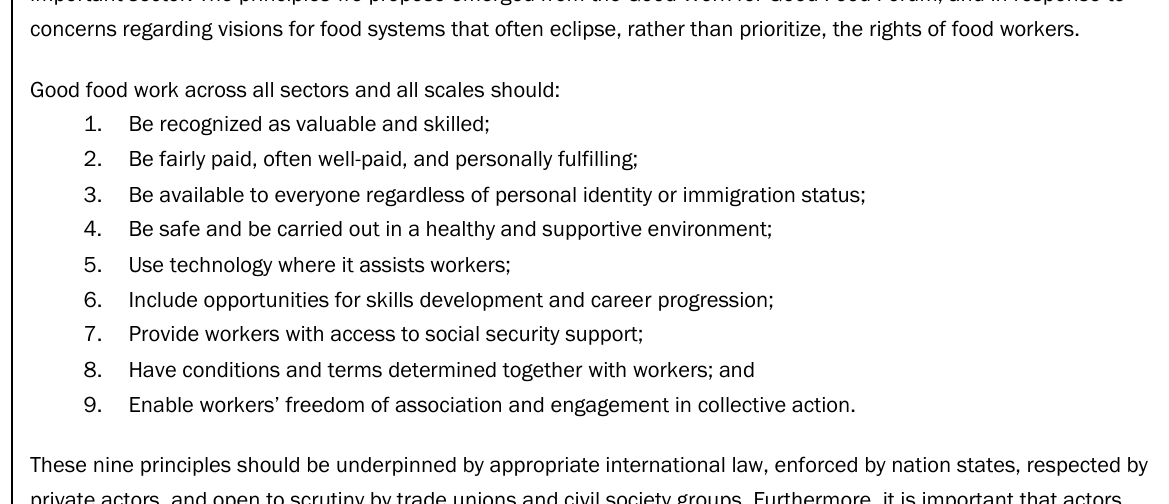
Figure 1. A Collective Vision for Good Food